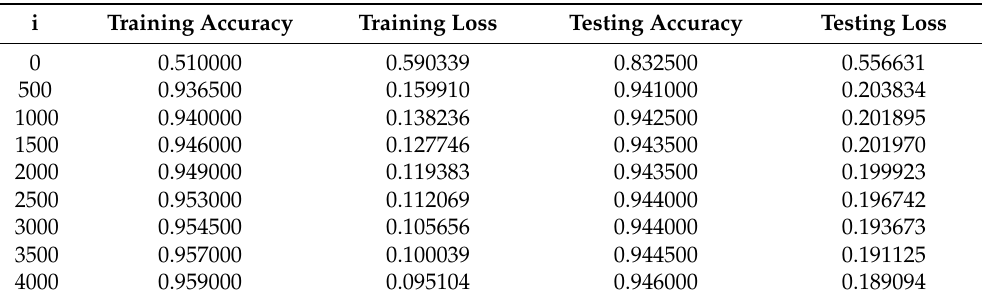
Table 4. The accuracy rate and loss rate of training dataset and testing dataset in R-G-B logistic